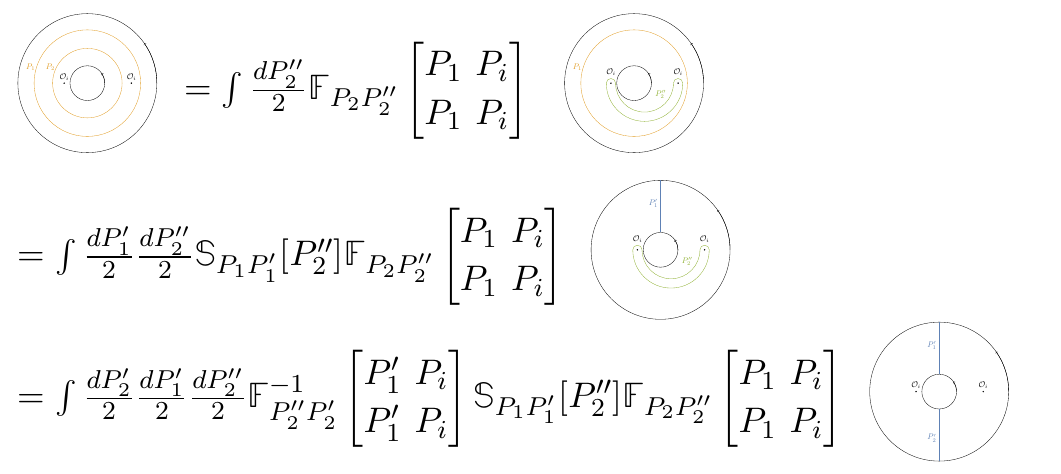
Figure 10 . The sequence of moves expressing a “bagel” channel conformal block (top left) in terms of “necklace” channel conformal blocks (bottom right) for a torus two-point function with identical bulk external operators. The corresponding crossing kernel is given in (C.2).